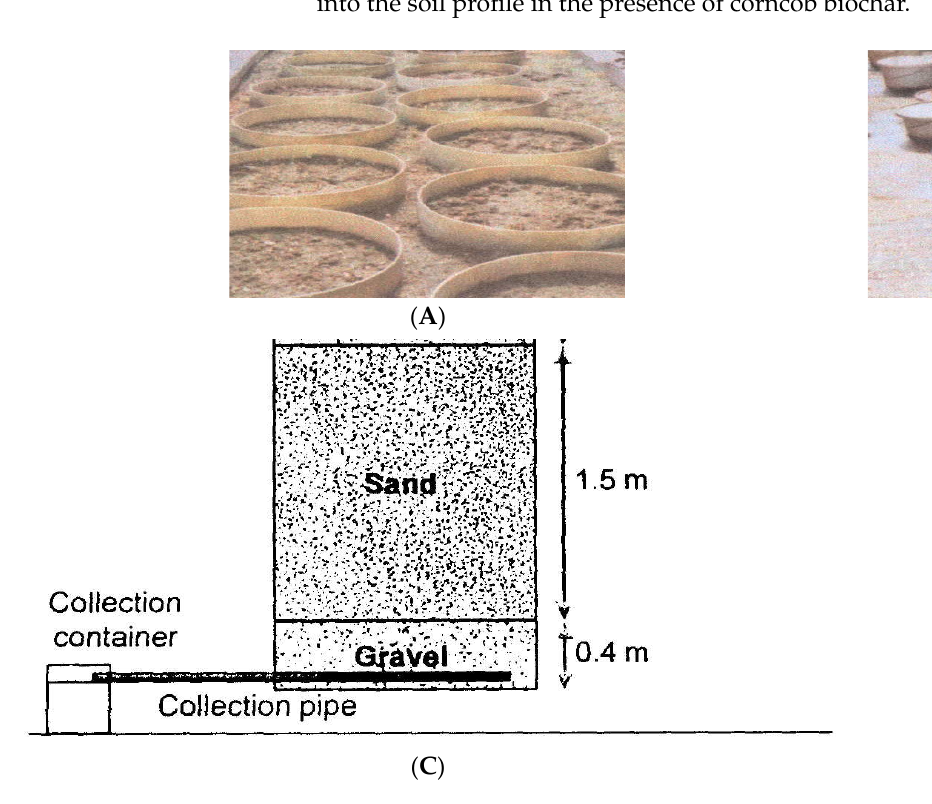
Figure 2. Lysimeter experiment construction. ( A ) Experimental lysimeters view. ( B ) Leachate collection buckets at the base of each lysimeter. ( C ) Schematic diagram of the lysimeter side elevation.